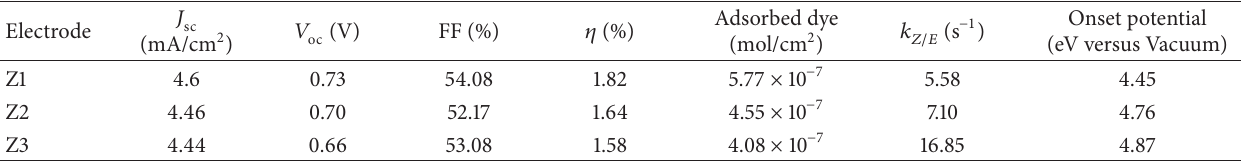
Figure 2: (a) Current density-voltage ( J-V ) characteristics of DSSCs with photoelectrodes of Z1, Z2, and Z3 grains. (b) Cyclic voltammograms (CVs) of the photoelectrodes in 0.5M LiClO 4 dissolved in acetonitrile at a scan rate of 50 mV/s. (c) The exponential distribution of the density of states (DOS) of different ZnO nanograins was deduced by capacitive charging of electrons into the surface states versus applied potential and (d) the Bode plots from electrochemical impedance spectroscopy of DSSCs. Table 1: Photovoltaic and kinetic parameters of Z1, Z2, and Z3 DSSCs photoelectrodes along with their amounts of adsorbed dye and the onset potential for exponential distribution of the density of states